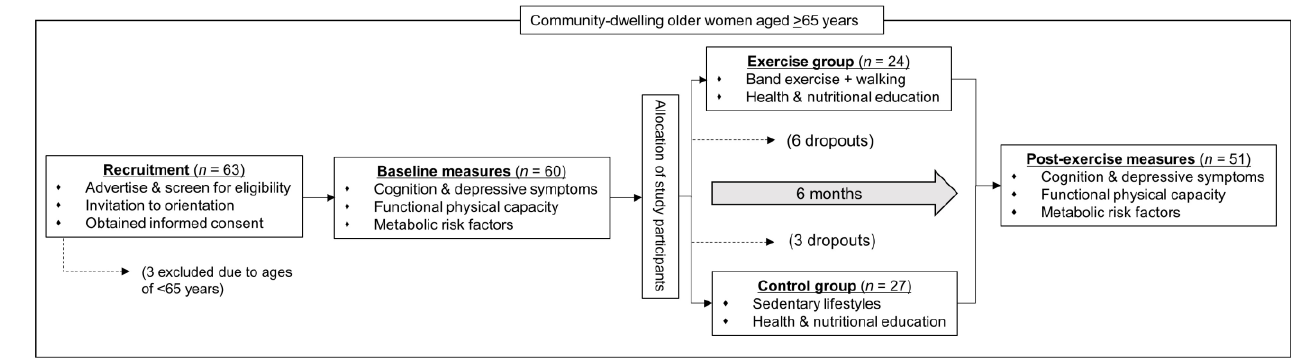
Figure 1. Illustration of overall study design and measurement procedure.